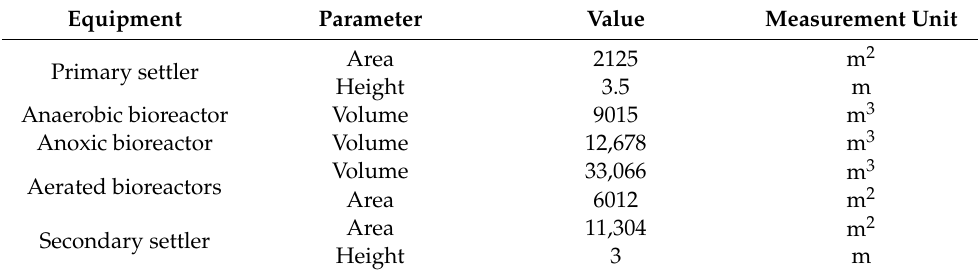
Table 1. Municipal WWTP main equipment parameters.